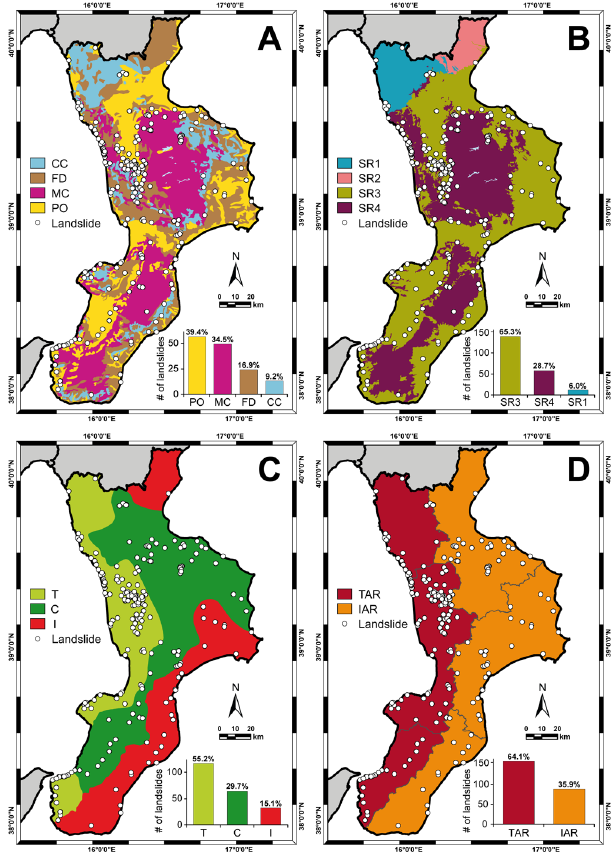
Fig. 6. Geographical distribution of shallow rainfall-induced land- slides (white dots) in Calabria, in the 16-year period from Jan- uary 1996 to September 2011, superimposed on maps of different environmental factors. Histograms show the number and the pro- portion of shallow landslides for each factor class. (A) Lithological domains: CC, carbonate rocks; FD, flysch deposits; MC, metamor- phic and crystalline rocks; PO, post-orogenic sediments. (B) Soil regions: SR1, Pollino range and neighbouring hills; SR2, northern Ionian coastal zone; SR3, coastal hills and plains; SR4, Sila, Serre and Aspromonte ranges. (C) Rainfall regions: T, Tyrrhenian region; C, Central region; I, Ionian region. (D) Civil Protection alert re- gions: TAR, Tyrrhenian alert region; IAR, Ionian alert